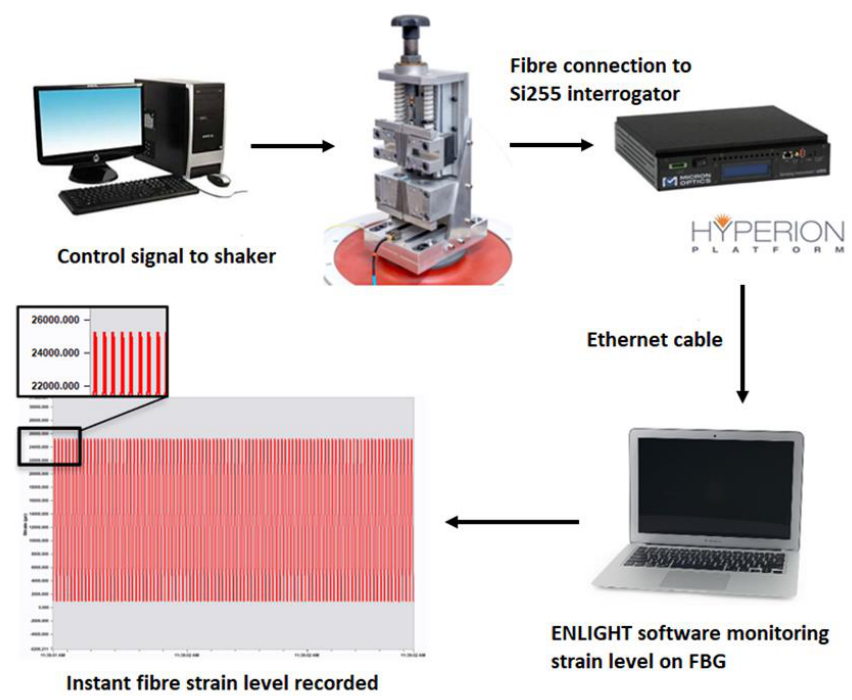
Figure 1. Experimental arrangement for fatigue cycling of fibre optic sensors.